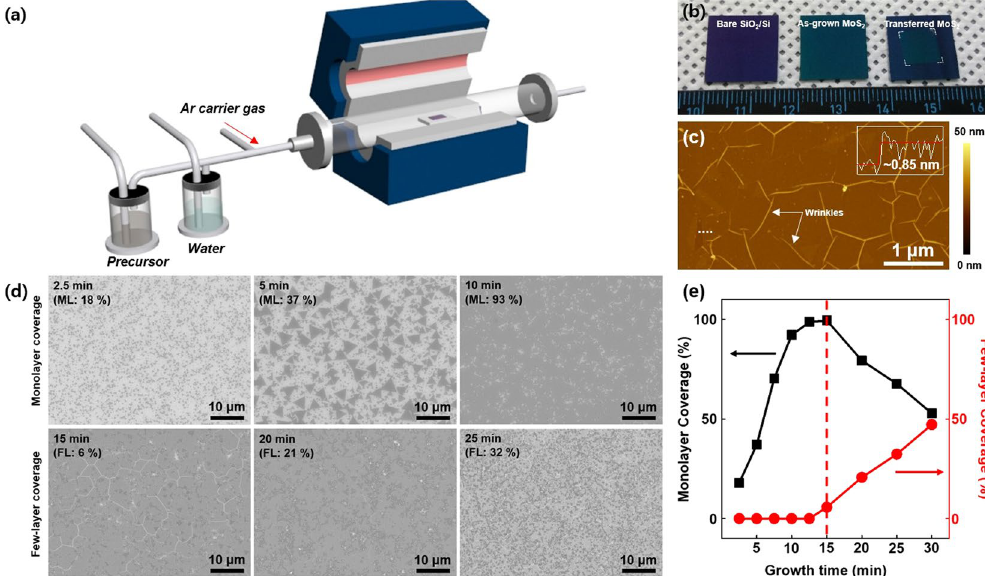
Figure 1. Synthesis of MoS 2 film. ( a ) Schematic illustration of the CVD system with a liquid precursor and water bubblers. The bubblers are connected with individual mass flow controllers. ( b ) Photographs of the bare SiO 2 /Si substrate, as-grown MoS 2 film, and transferred MoS 2 film. ( c ) Atomic force microscopy image of the transferred MoS 2 film. The inset indicates the height profile along the dotted white line. The white arrows present the MoS 2 wrinkles. ( d ) SEM images of as-grown MoS 2 as a function of the growth time. The dark region indicates MoS 2 , and the white background indicates the SiO 2 /Si substrate. The coverage for monolayer (ML) and few-layer (FL) MoS 2 is displayed in each SEM image. ( e ) The coverage for monolayer (black) and few-layer (red) MoS 2 regions as a function of the growth